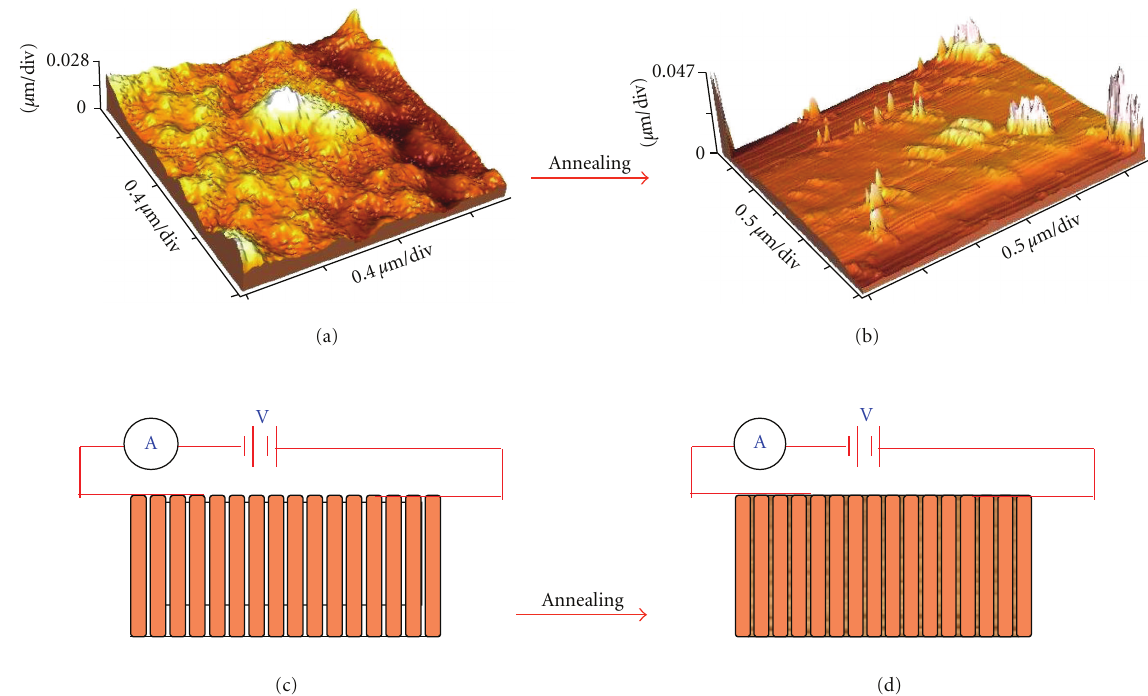
Figure 6: (a) AFM images of as deposited 50 nm ZnO thin film, (b) annealed at 400 ◦ C for 1 hour. Schematic views of ZnO thin film before (c) and after annealing